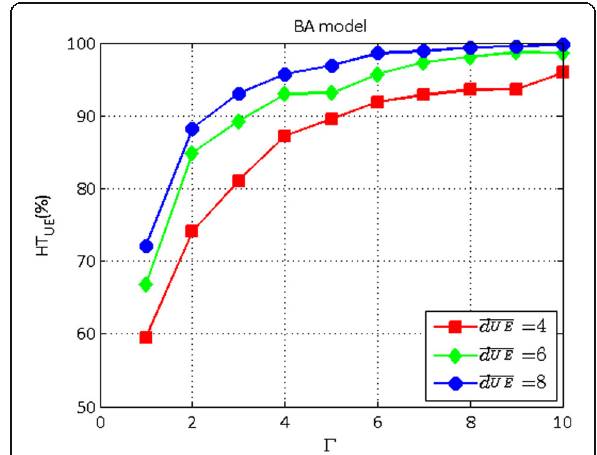
Fig. 10 Impact of average degree value to hit rate in BA